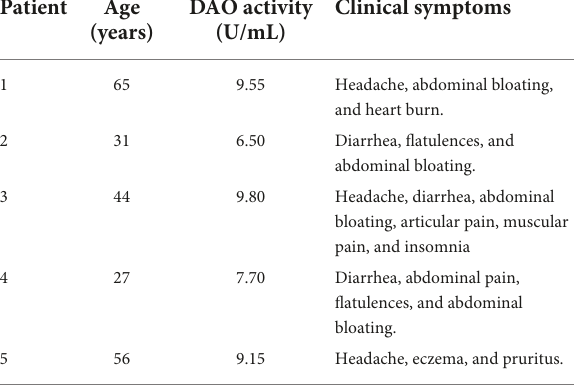
TABLE 1 Baseline characteristics of each patient with histamine